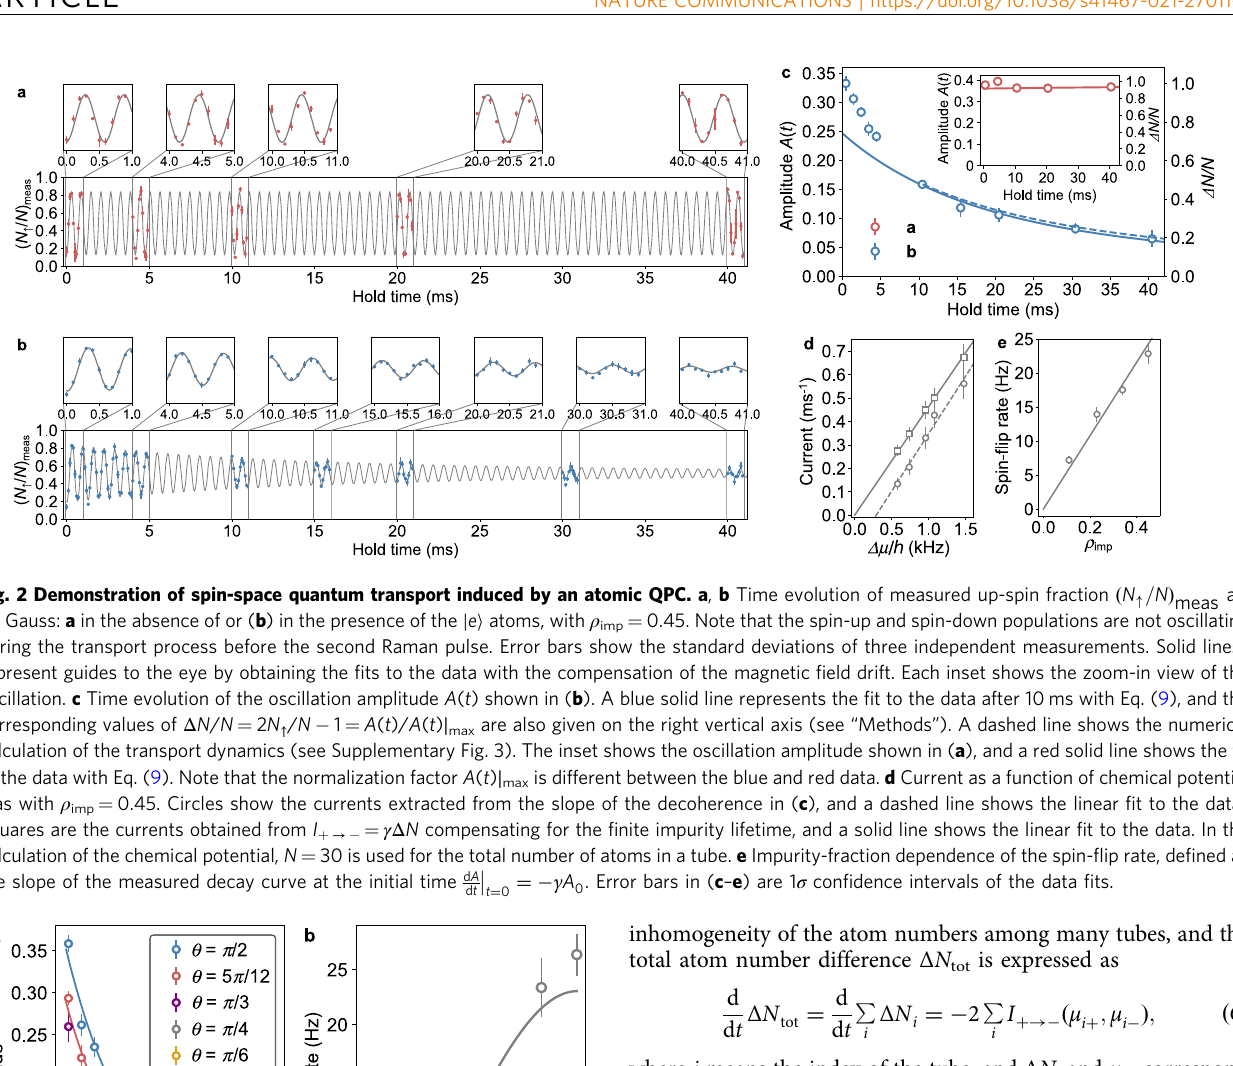
Fig. 2d. As a result, we obtain the linear dependence between the current and chemical potential bias, indicating the ohmic conduction. The conductance, de fi ned as I + → − = G Δ μ , is obtained as G = 0.45/ h .